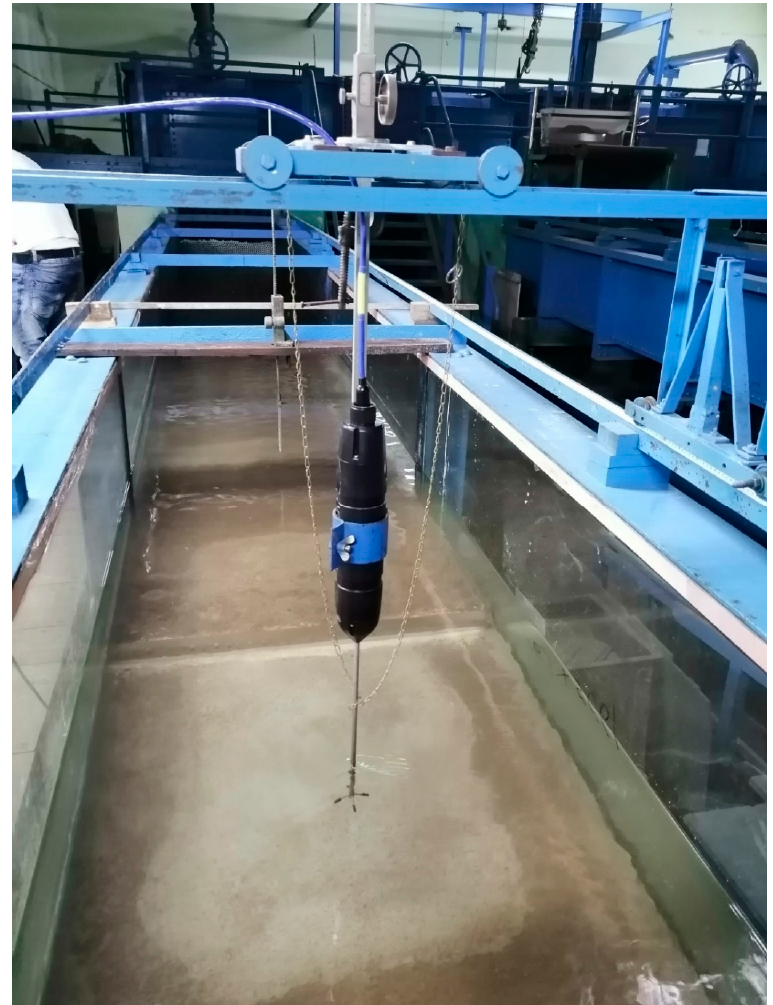
Figure 2. The flume setup for the sand-bed (Run 1 and Run 2).